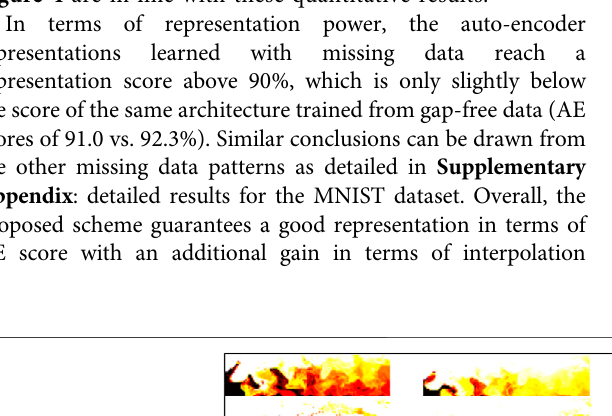
Frontiers in Applied Mathematics and Statistics |